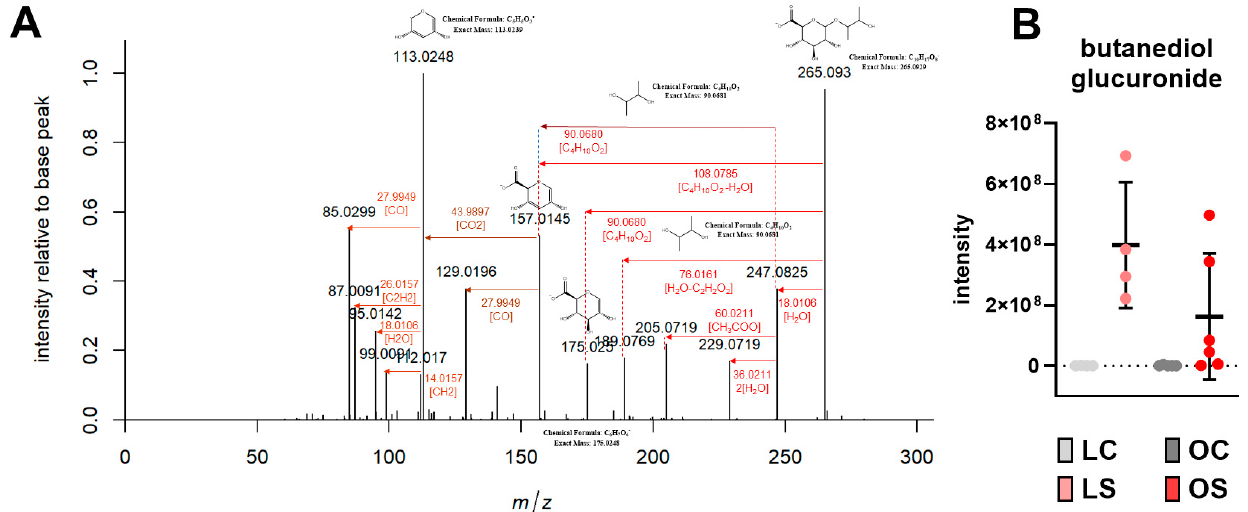
Figure 3. Metabolomics results in liver. Fragmentation pattern of the metabolite C010 ( m/z 265.0930) tentatively identified as butanediol glucuronide ( A ); Intensity of the metabolite C010, as butanediol glucuronide, in the liver samples of the animals with differences in diet ( p < 0.05) ( B ). LC, lean control; LS, lean supplemented with sofrito ; OC, obese control; OS, obese supplemented with sofrito